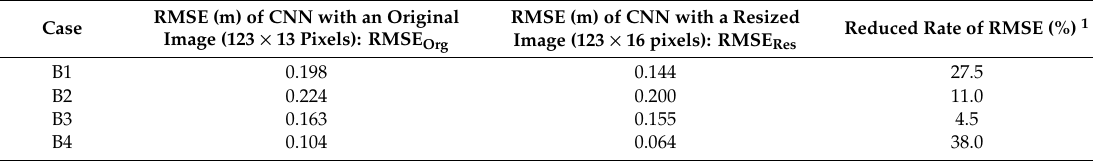
Table A2. Error evaluation of CNN between an original image and a resized image in Domain B. RMSE (m) of CNN with an Original RMSE (m) of CNN with a Resized Case Image (123 × 13 Pixels): RMSE Org Image (123 × 16 pixels): RMSE